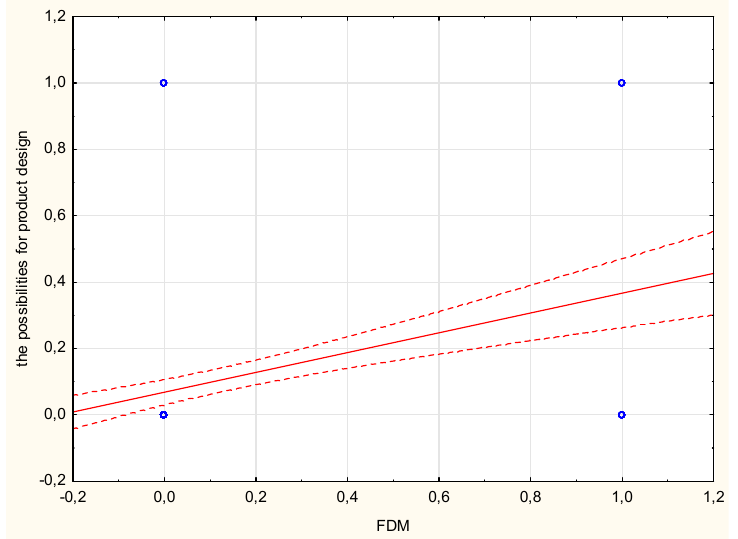
Figure 7. Interactions between using Fused Deposition Modelling ( FDM) and increasing the possibilities for product design.